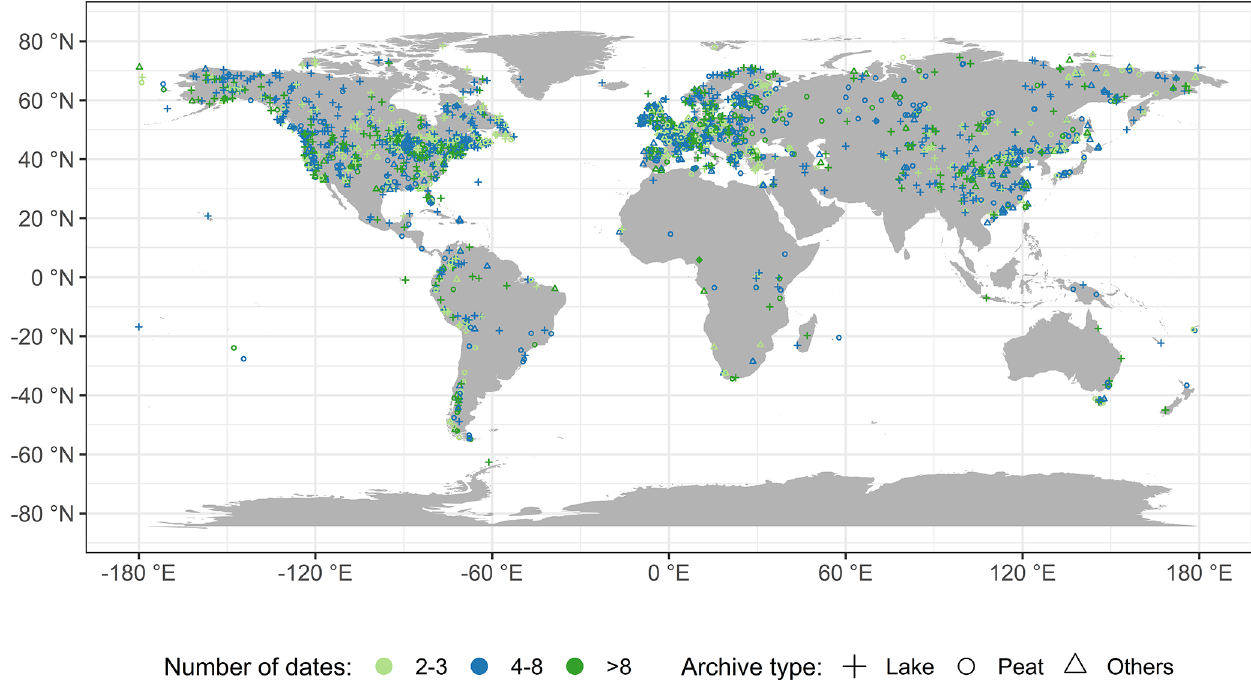
Figure 3. Map of the number of dates and archive types for each record.